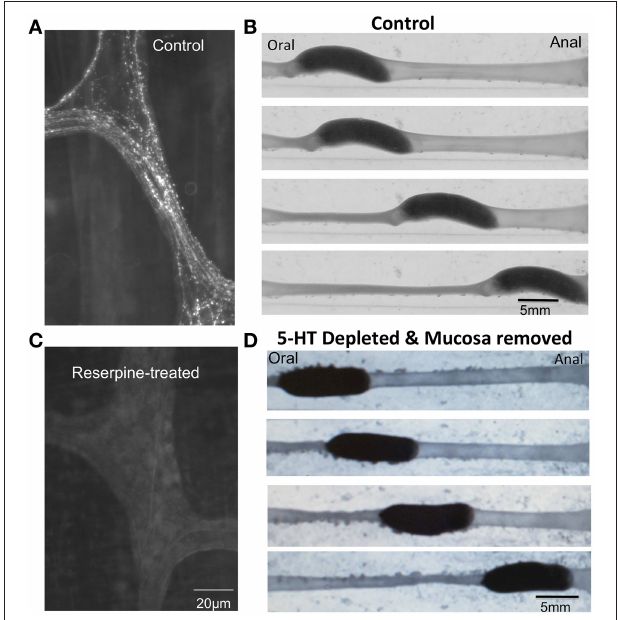
FIGURE 1 | (A) Immunohistochemical staining of a myenteric ganglion with antibodies against 5-HT. Varicose 5-HT immunoreactive nerve axons ramify within myenteric ganglia and internodal strands. (B) Distension-evoked peristalsis elicited by insertion of an artificial fecal pellet. (C) After injection of reserpine into conscious guinea-pigs, all 5-HT is depleted from enteric ganglia. (D) Despite removal of all the mucosa and submucosal plexus and depletion of 5-HT from myenteric ganglia, distension-evoked peristalsis still reliably occurs.